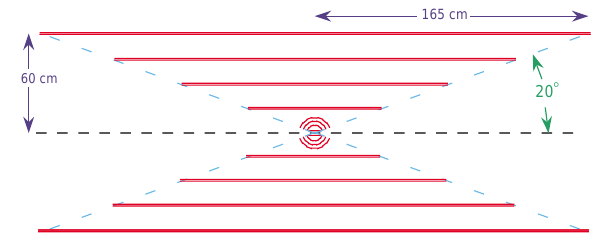
FIG. 75. (Color) Compact tracker geometry in a 4 T